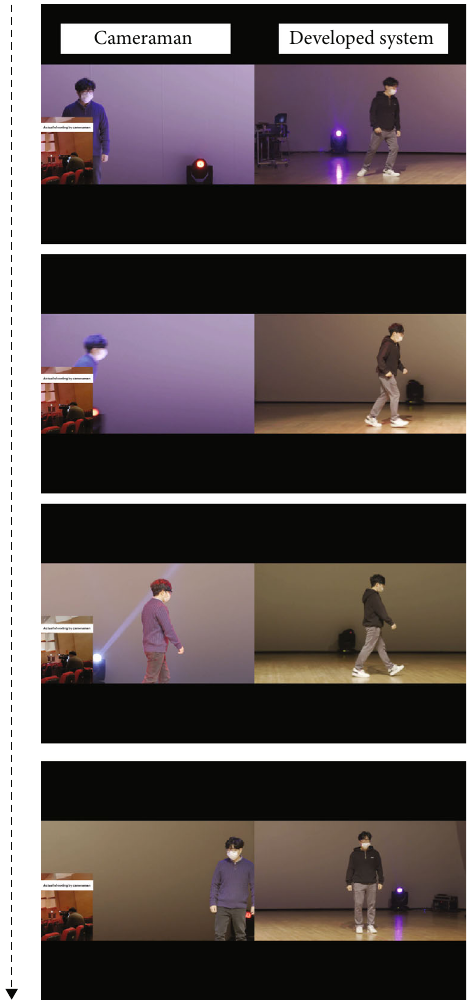
Figure 9: Comparison of video shot by an actual camera operator and that using the developed